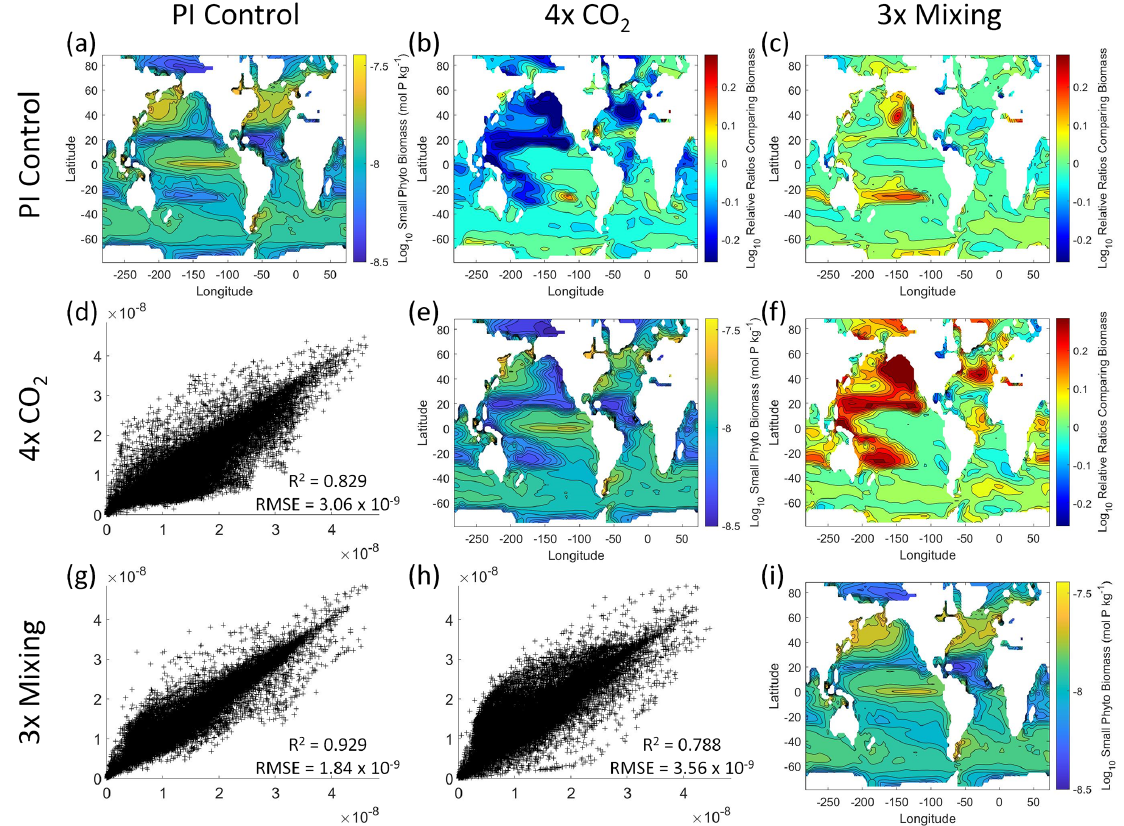
Figure 5. Comparison of the model runs for small phytoplankton biomass in Case 1. The units for biomass in all panels aremolPkg − 1 . The panels show point-by-point scatter plots comparing the model runs against one another (d, g, h) , yearly averaged log 10 biomass plots for each model run (a, e, i) , and the log 10 relative ratios comparing the yearly averaged contour plots of the model runs (b, c, f) . The x axis and y axis of the scatter plots (d, g, h) correspond to the horizonal and vertical model run labels, respectively (e.g., panel d shows PI Control on the x axis and 4 × CO 2 on the y axis). The yearly averaged log 10 contour plots (a, e, i) correspond to the matching horizontal and vertical model run labels (e.g., panel a shows the yearly averaged log 10 biomass of PI Control). The log 10 relative ratios (b, c, f) were calculated as the model run listed on the horizontal axis divided by the model run listed on the vertical axis (e.g., panel b shows 4 × CO 2 divided PI